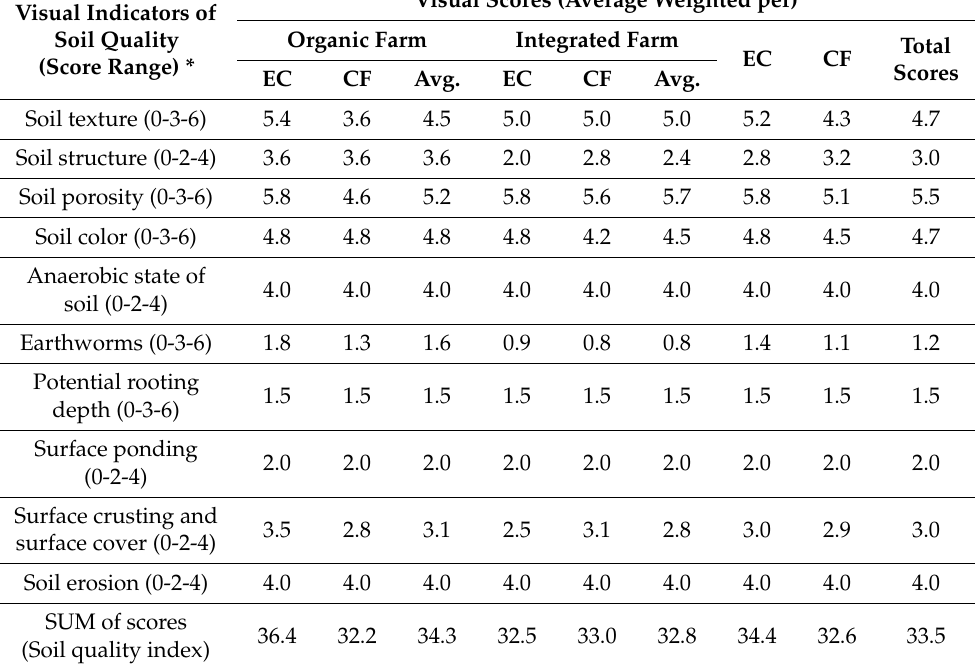
Table 2. Results of visual indicator scores for visual soil assessment (VSA) as an average weighted score and sum of scores of all assessments for organic and integrated farms and Eutric Cambisol and Calcaric Fluvisol in the year 2017. Visual Scores (Average Weighted per) Visual Indicators of Organic Farm Integrated Farm Soil Quality Total EC CF (Score Range) * ScoresEC CF Avg. EC CF Avg.